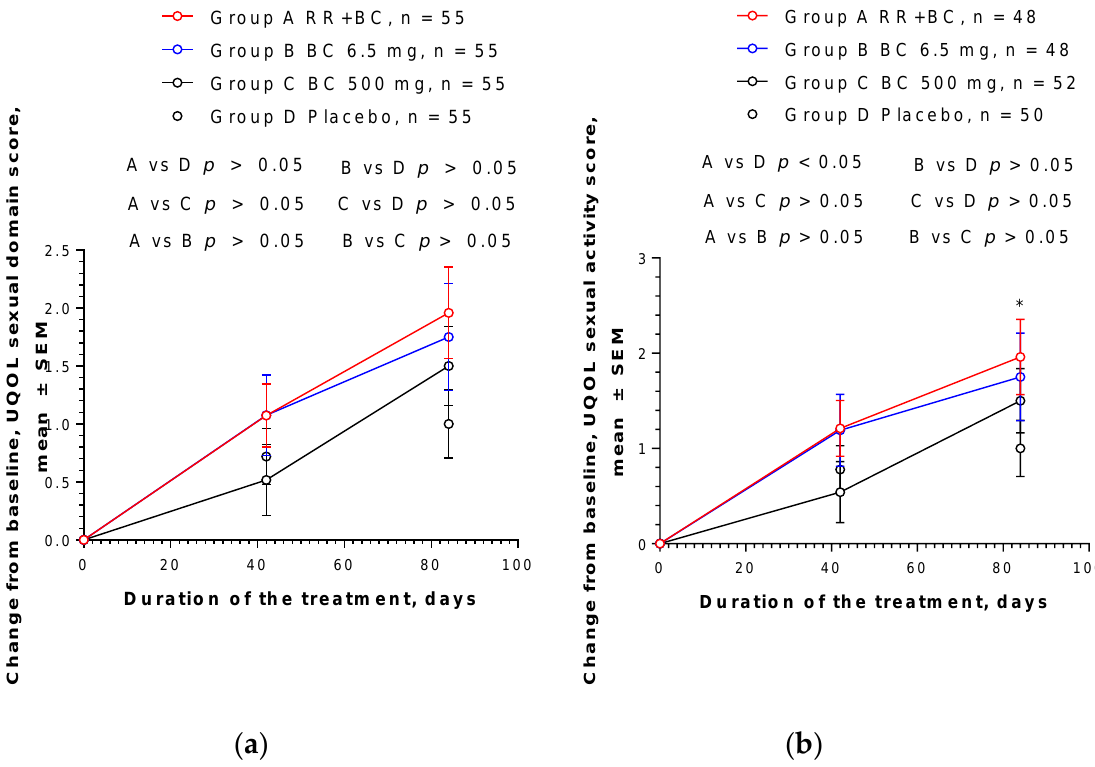
Figure A6. The change from baseline of menopause UQOL sexual domain scores (mean ± SD) over time: ( a ) -ITT analysis, ( b ) -PP analysis. Significance of difference between groups at various time points, calculated by Bonferroni post-test, is expressed by symbols * p < 0.05, ns: not significant (A, B, C vs. placebo).